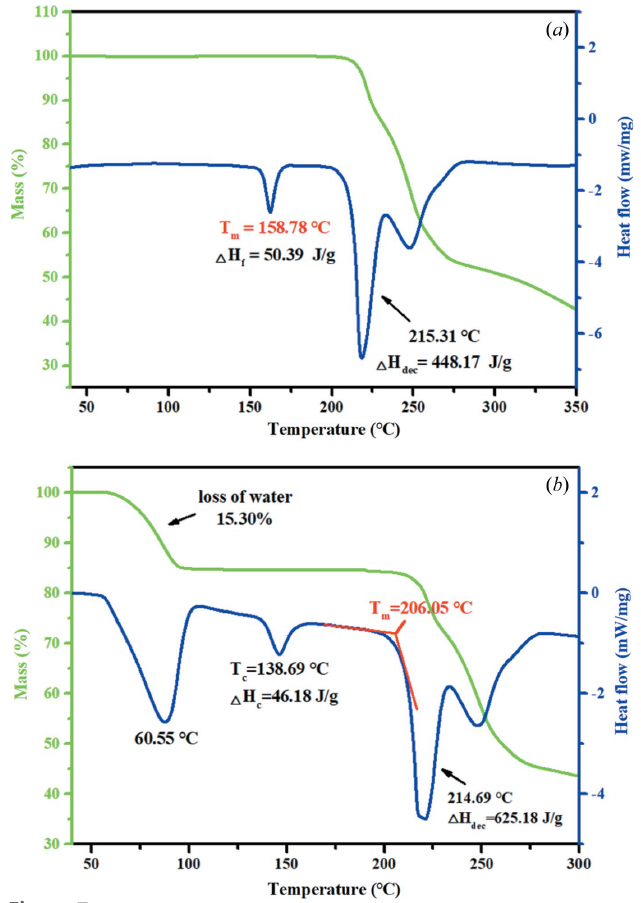
Figure 7 TGA and DSC curves of the ( a ) anhydrate and ( b ) dihydrate of PDA-